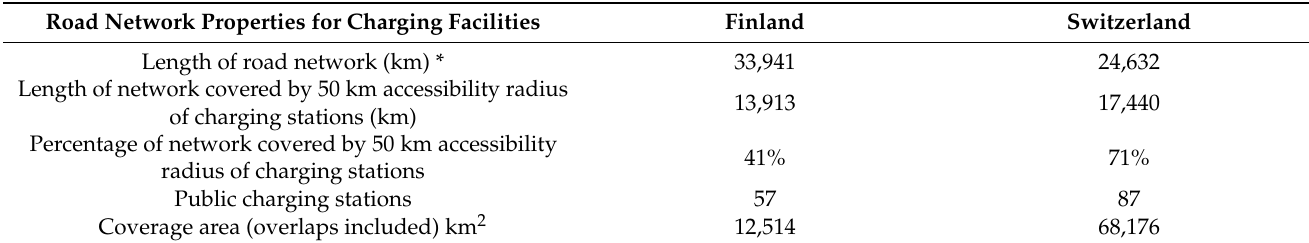
Table 5. Comparative coverage of charging service areas of the fast charging stations on Finnish and Swiss roads at the beginning of 2020 [41].